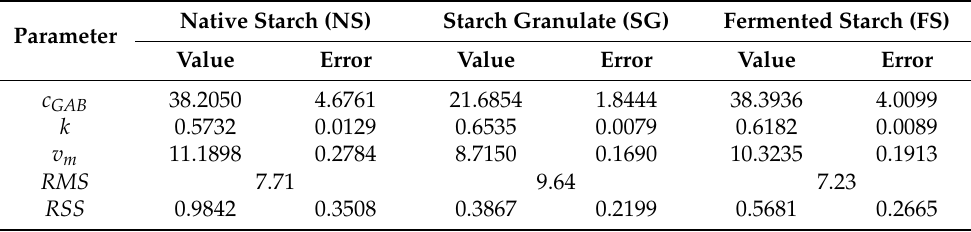
Table 4. Parameters of GAB equation determined for the analyzed cassava starches.